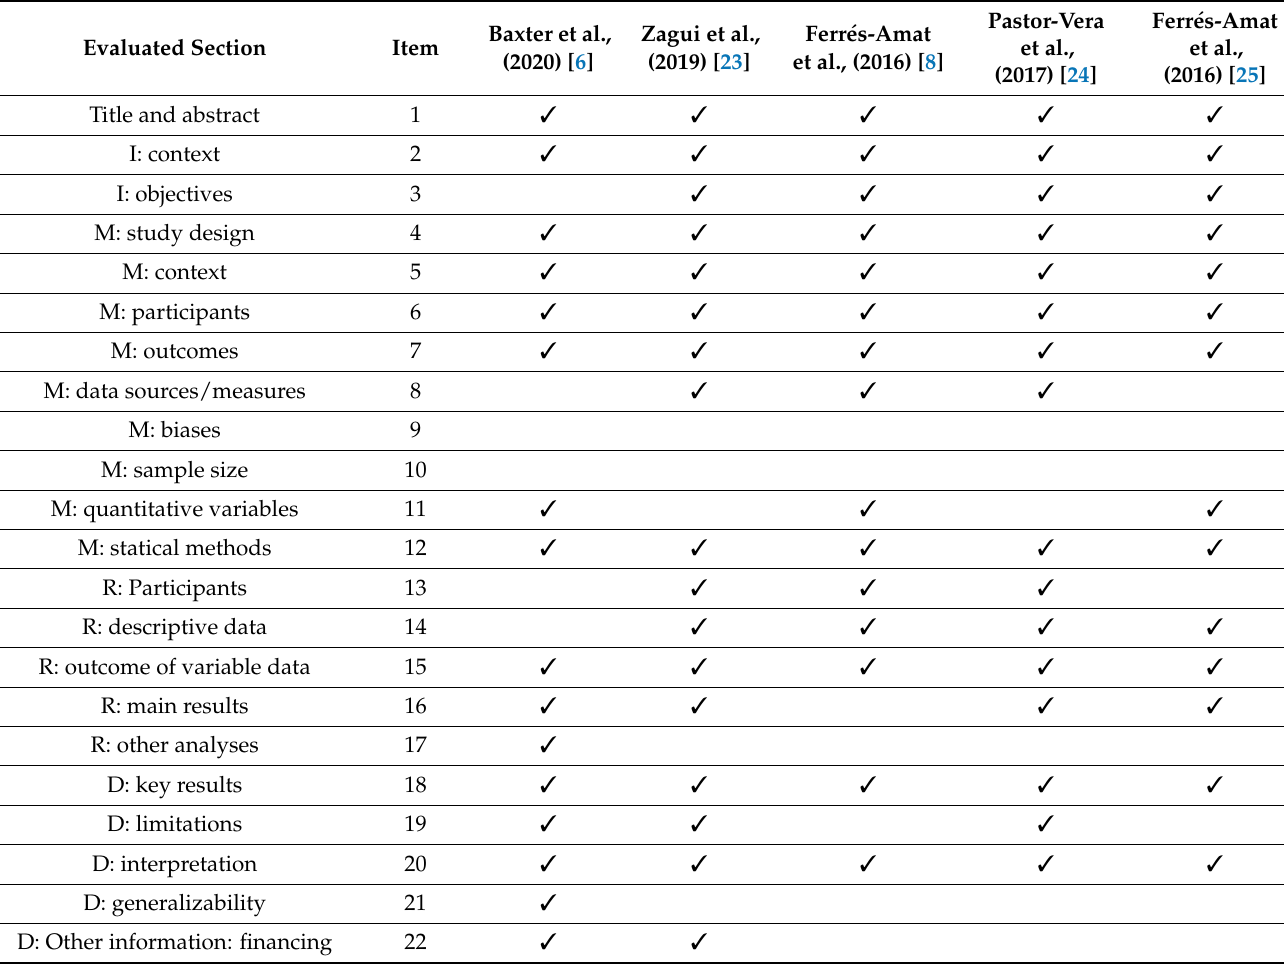
Table 4. Quality Assessment of Observational Studies using the STROBE Statement